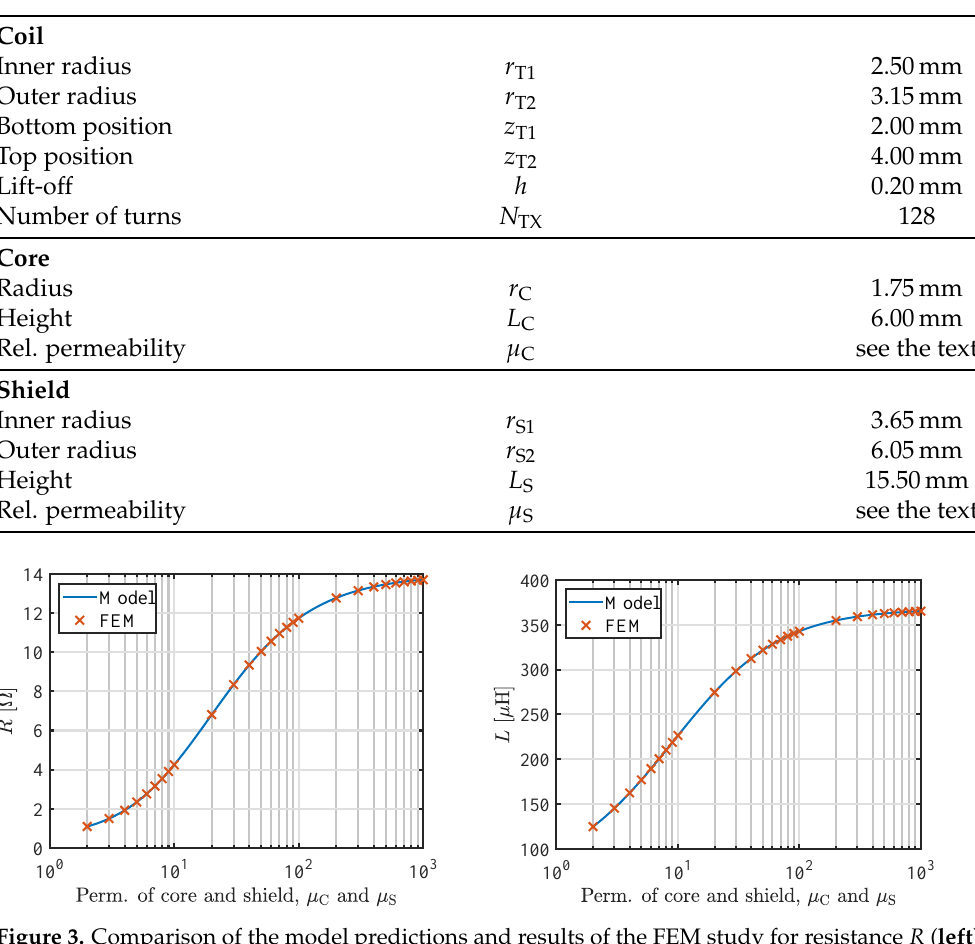
Table 1. Properties of the sensor used in the numerical studies.